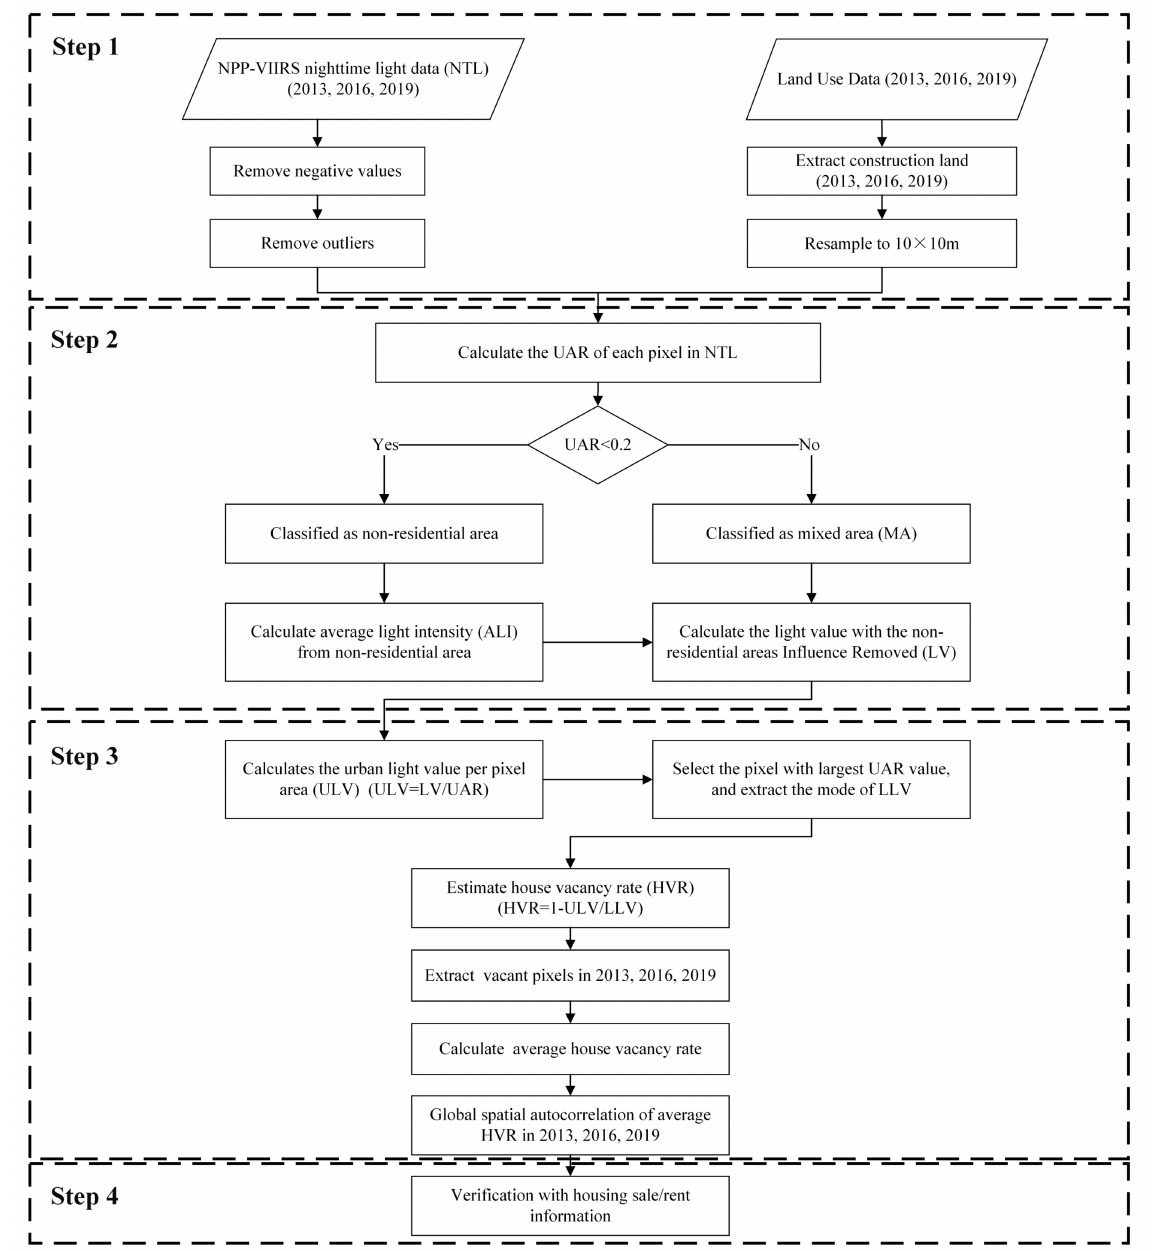
Figure 3. The flowchart of the proposed